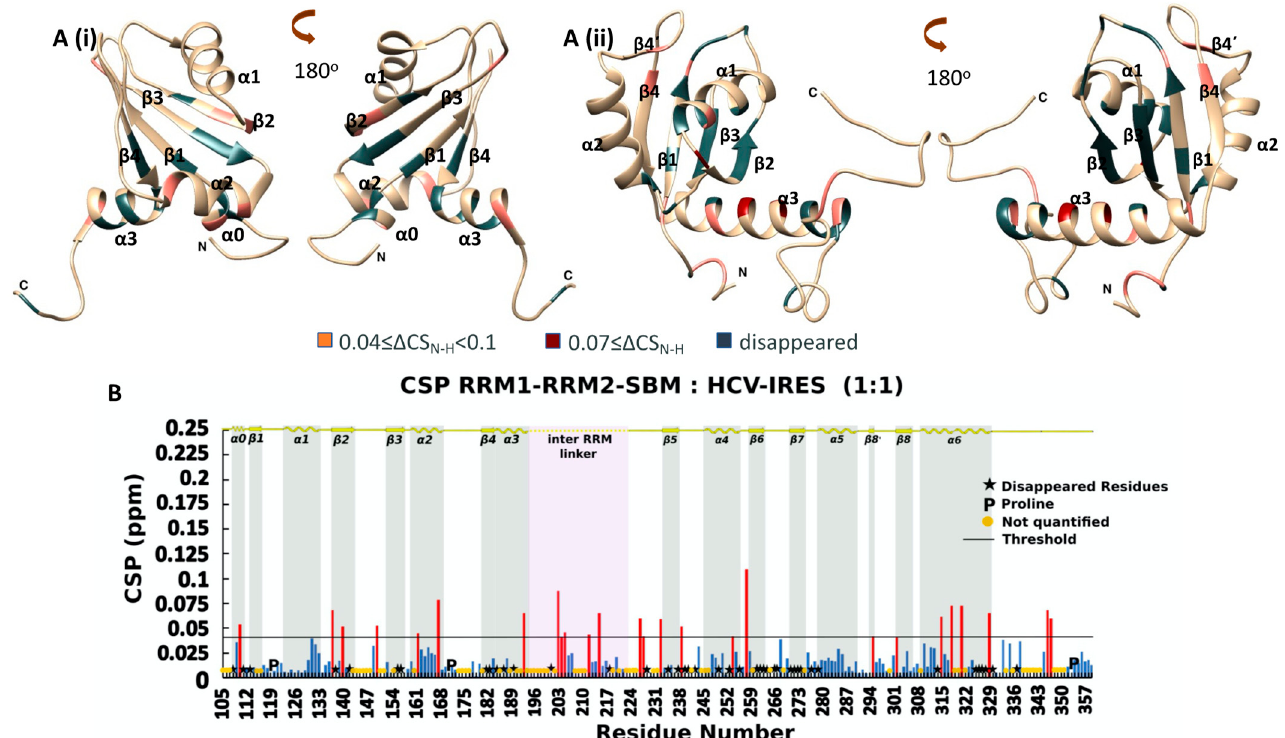
1:1 ratio (Figure 5B) revealed that the CSP values (Equation (1)) of 26 NHs were above the threshold value, which is 0.04 (calculated as described above), and 43 NH peaks disappeared due to the addition of HCV-IRES, with most of the affected NHs belonging to RRM2 residues. Specifically, 20 out of 69 affected residues are located in the RRM1 domain, 7 in the linker between RRM1 and RRM2, and 42 in the RRM2-SBM region (Figure 5A and Figure S9).